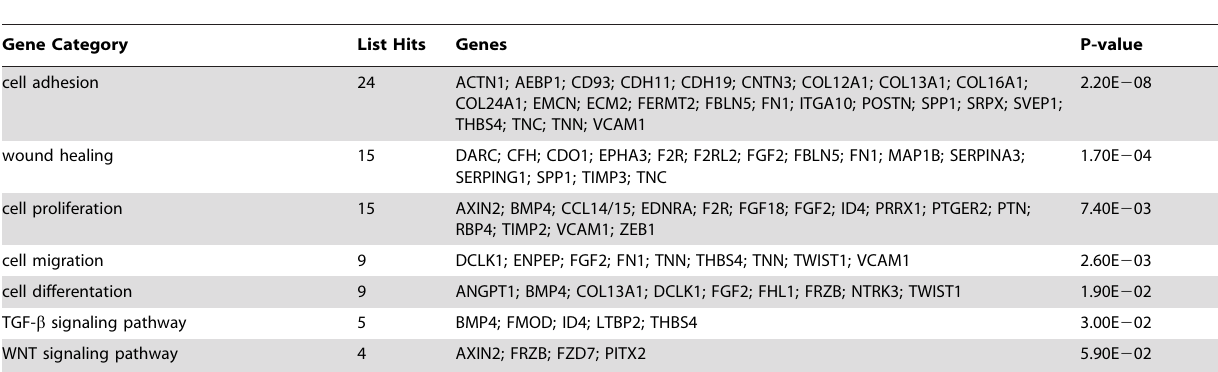
Table 1. Preferentially Expressed Limbal Genes Grouped by Biological